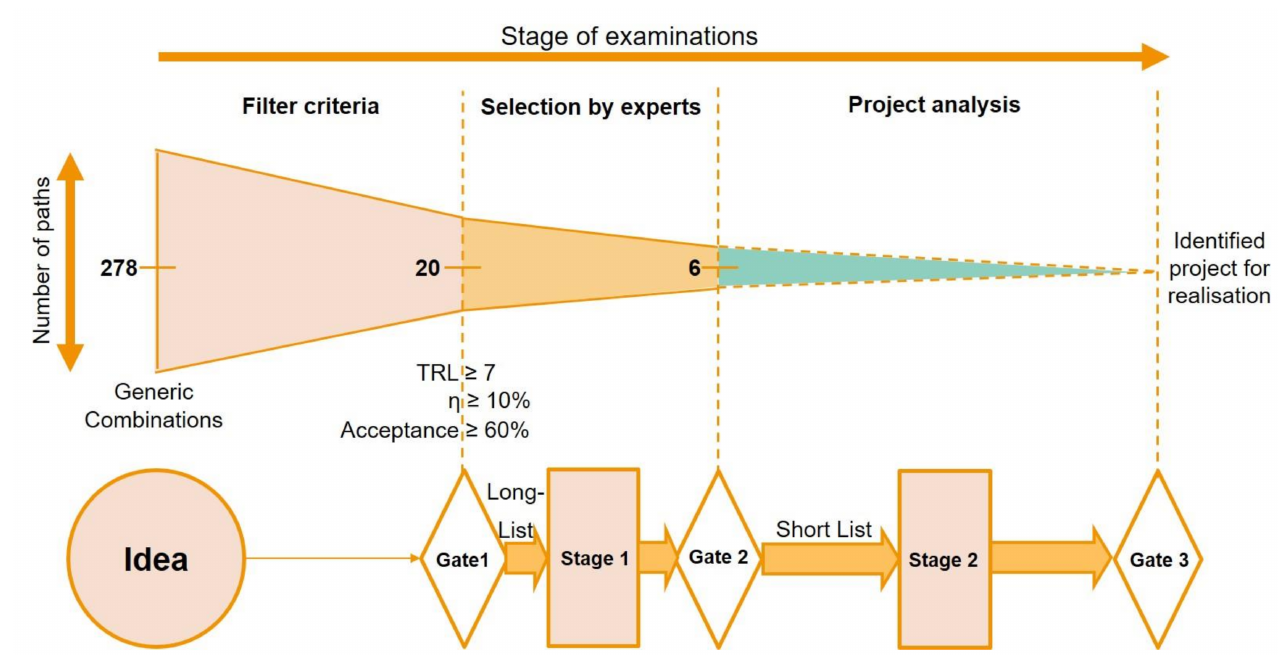
Figure 2. Summary of the stage gate process (based on [18]) and the selection of